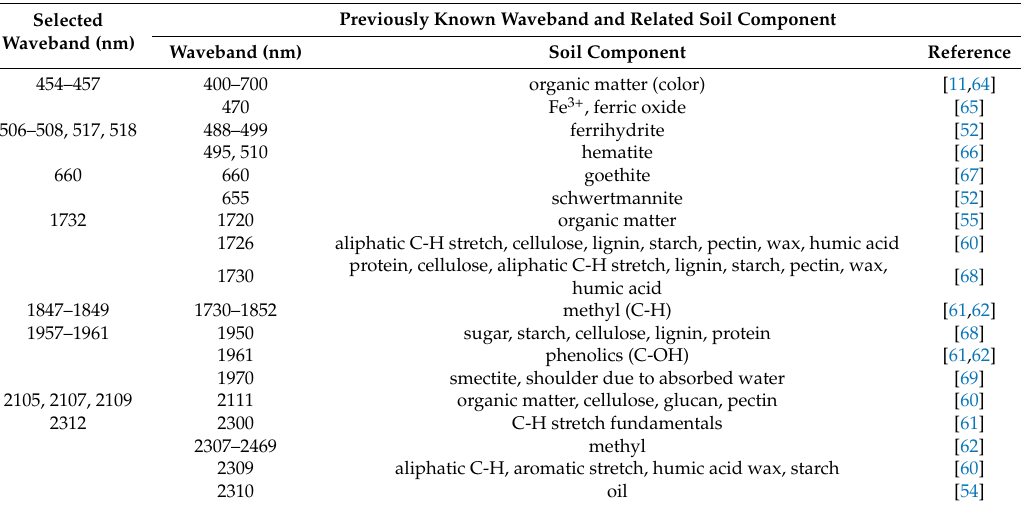
Table 3. Commonly selected wavebands from five GA-PLS runs to estimate soil oxalate-extractable P using the FDR data set ( n = 103) and possible soil